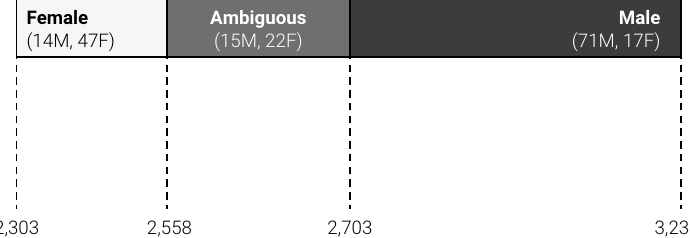
Figure 2. Sex diagnosis according to the nasozigomatic triangle area (in mm 2